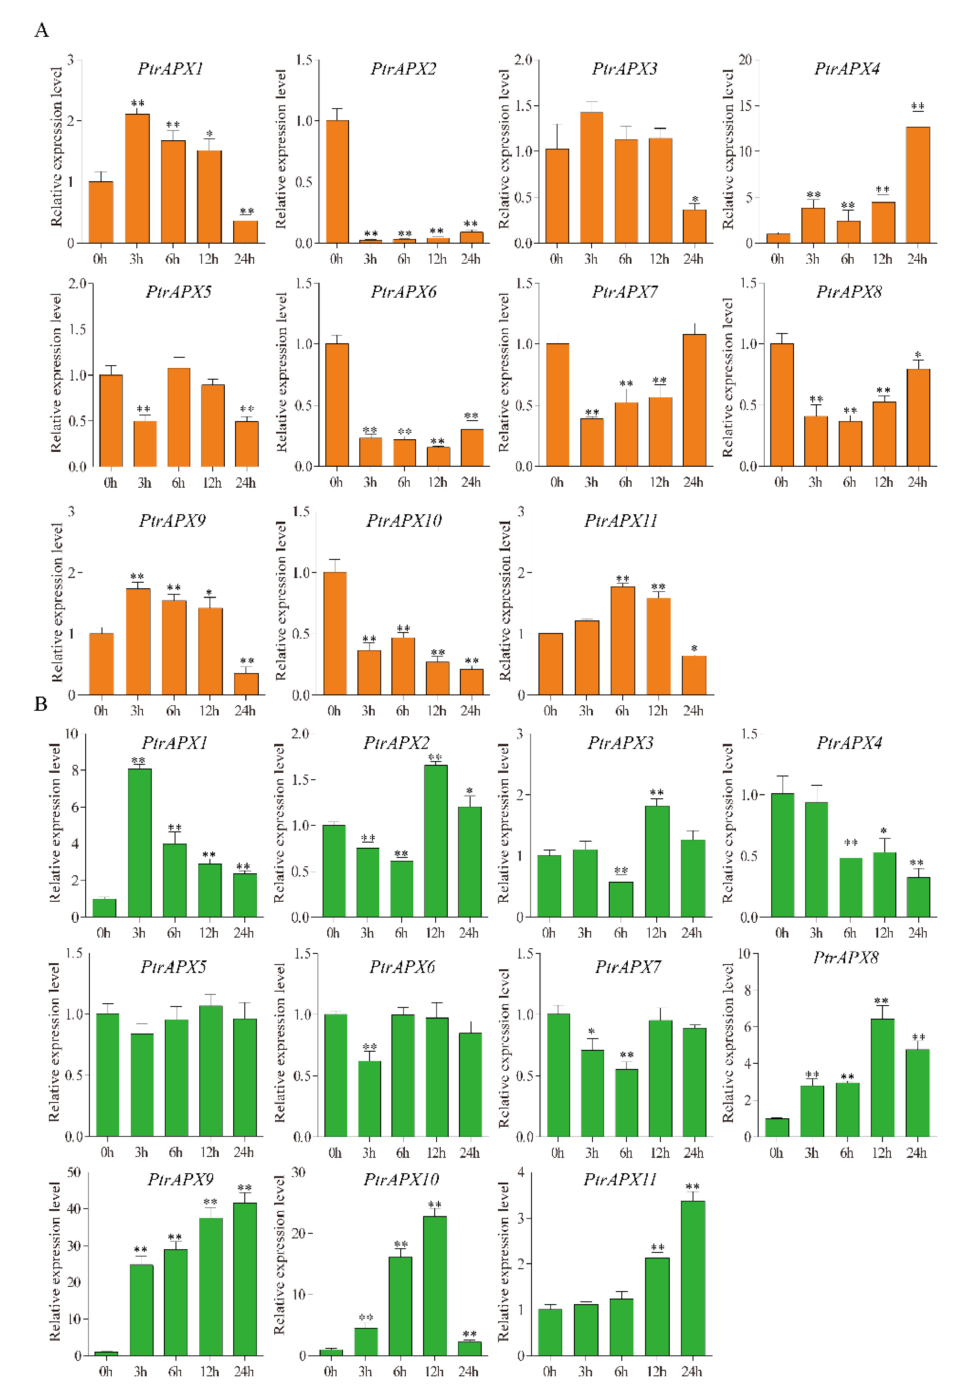
Figure 8. Relative expression level of PtrAPX genes under drought stress estimated by RT-qPCR. The expression pattern of PtrAPX genes in roots ( A ) and leaves ( B ) is shown. Error bars represent the standard deviations from three biological replicates. The x-axis represents time points after PEG treatment. Asterisks indicate stress treatment groups that showed a significant difference in transcript abundance compared with the control group (* 0.01< p < 0.05, ** p <